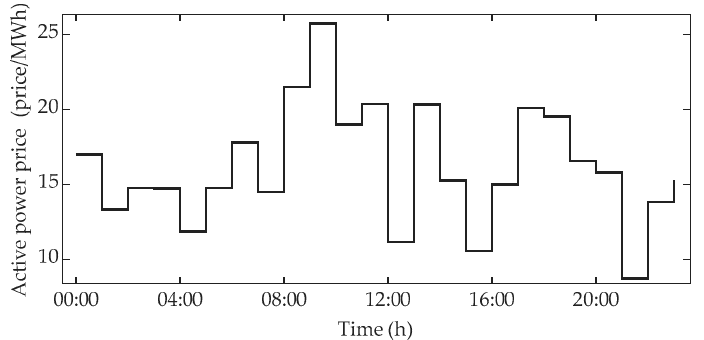
Figure 6. Illustrative active power price curve (b P − curve) with 1-h periods for 24 h period.